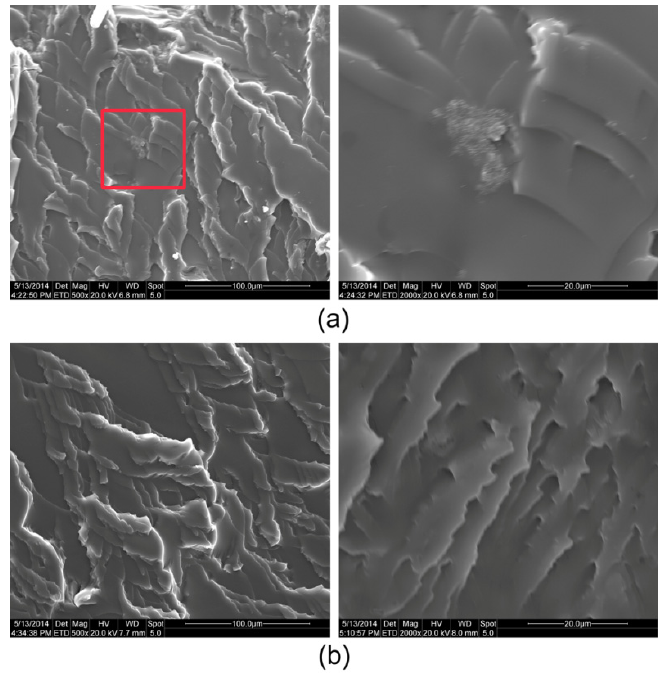
Figure 7. SEM images of TE ( a ) and TE/CNTs-PA ( b ) nanocomposites. Figure 7 . SEM images of TE ( a ) and TE/CNTs ‐ PA ( b ) nanocomposites.